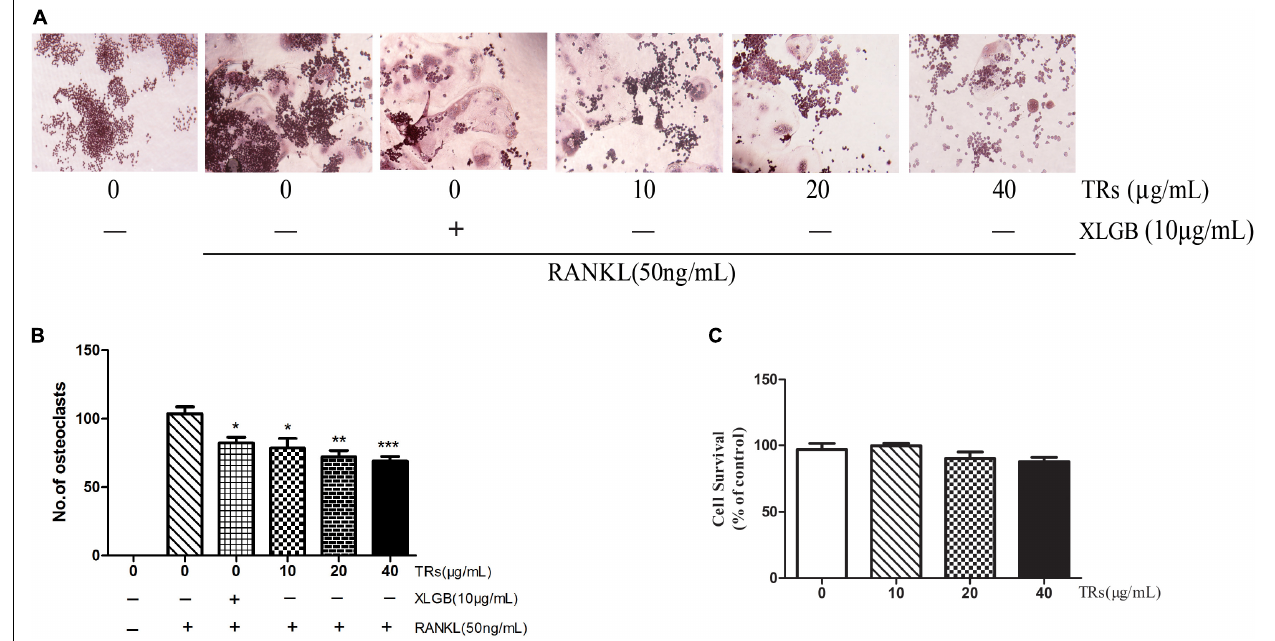
FIGURE 6 | The effect of thearubigins (TRs) on osteoclastogenesis. (A,B) The TRAP staining test was used to determine the effects of TRs on the differentiation of RAW264.7 cells into osteoclasts (magnification × 200). The numbers of osteoclasts in each sample were counted and quantified. (C) The MTT assay was used to determine the survival of RAW264.7 cells in the presence of the different concentrations of TRs. All data are presented as the mean ± SEM ( n = 3). “One way ANOVA” was used for the comparison of BTE treatment vs only RANKL treatment. ∗ p < 0.05, ∗∗ p < 0.01, and ∗∗∗ p < 0.001 vs only RANKL